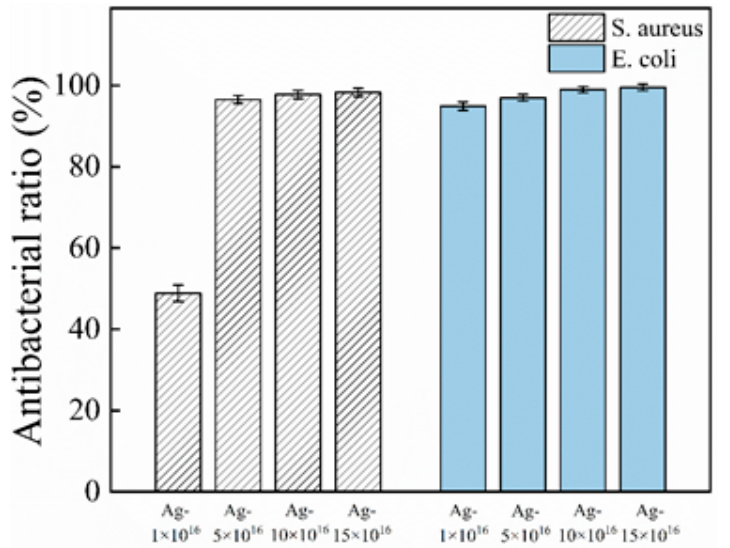
Figure 12. Antibacterial ratios of the re-cultivated S. aureus and E. coli colonies on agar for different doses of Ag-implanted specimens.